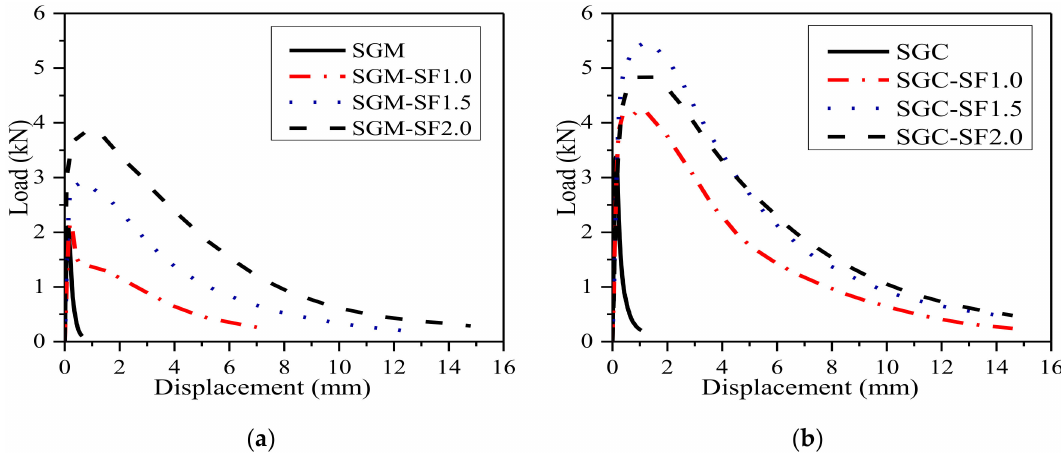
Figure 5. P- δ curves of plain and steel fiber-reinforced SGM/SGC. ( a ) SGM; ( b )